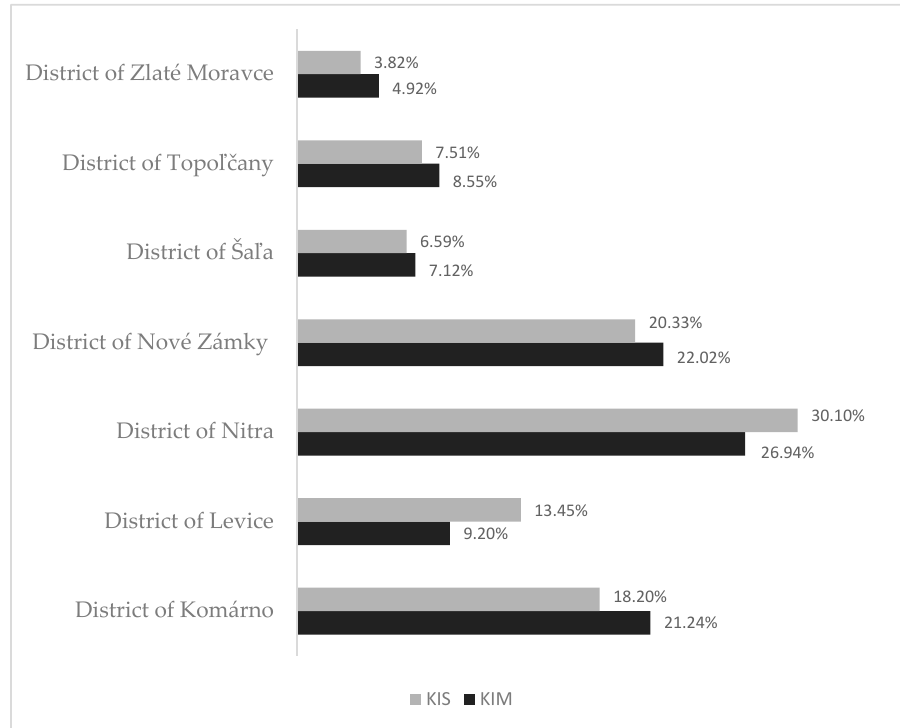
Figure 1. Localization of KIM and KIS enterprises in Nitra-region districts.